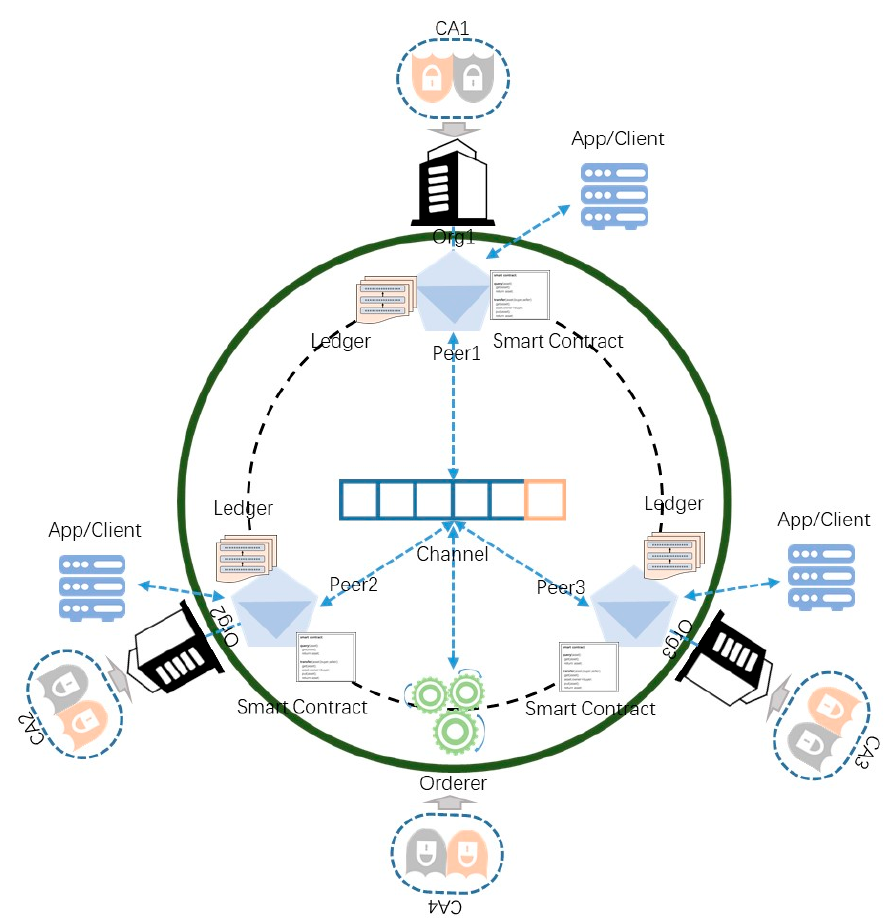
Figure 2. Network-topology architecture.